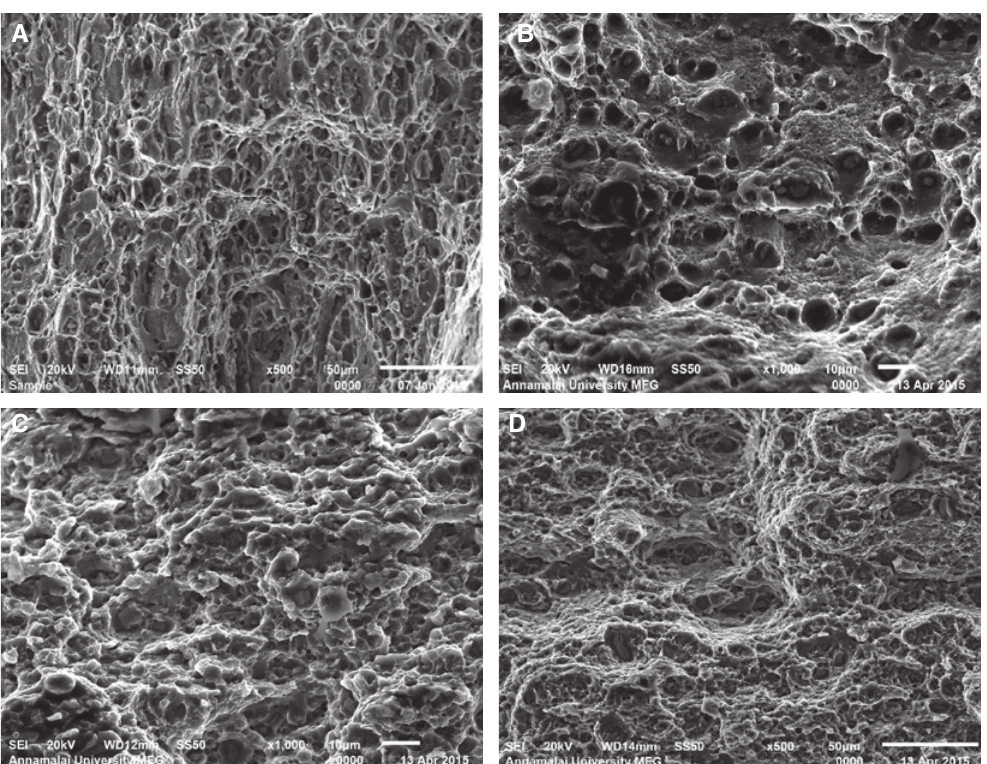
Figure 12: SEM-fractographs of (A) PM, (B) AW, (C) AA, (D) STA